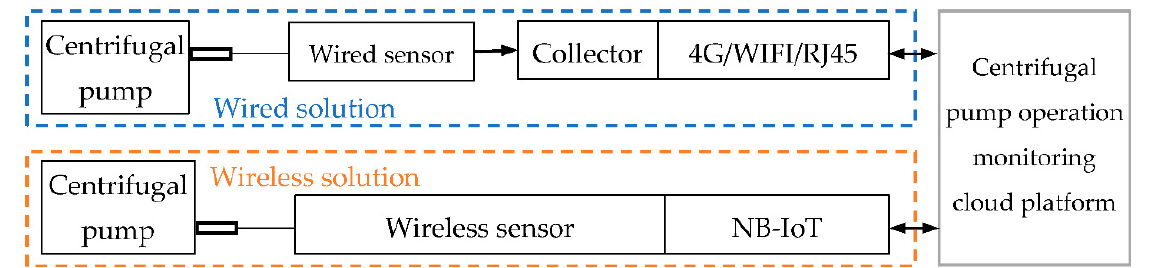
Figure 2. System topology diagram of the smart collection equipment.